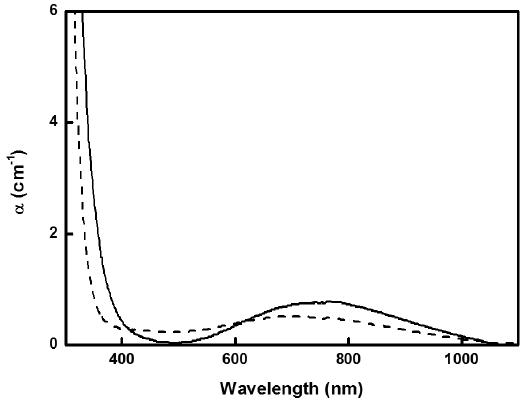
Figure 3. Absorption spectra of the copper doped borate (solid) and borosilicate (dash) glasses. Table 1. Glass transition temperature (T sample surface. Glass